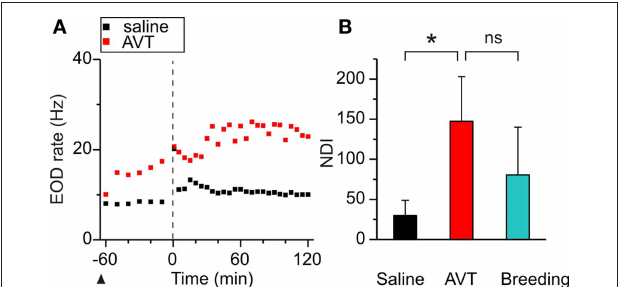
FIguRE 3 | Effects of AVT upon the nocturnal increase of EOD rate in non-breeding Brachyhypopomus gauderio. (A) EOD rate as function of time (60 min before artificial sunset to 120 min after, lights off at time = 0, vertical line) in one representative male–female dyad (female data not shown) following Protocol II. Saline was administered to the male 65 min before sunset (arrowhead) and a slight increase of EOD rate was observed during the night (day 2, Protocol II). In day 3, AVT (10 μg/gbw) was administered to the male 65 min before sunset (arrowhead) that evoked an immediate increase of its EOD rate followed by an additional nocturnal increase. (B) Nocturnal EOD rate increase (NDI) of males from different male–female dyads: non-breeding saline controls (Protocol II, day 2), non-breeding males injected with AVT (Protocol II, day 3), and breeding courting males (Protocol II, day 1, breeding). Bars represent medians (IQR) of night–day indexes (NDI, see Materials and Methods). * p < 0.05, Wilcoxon Matched-Pairs test. Mann–Whitney U test (breeding vs non-breeding). ns: